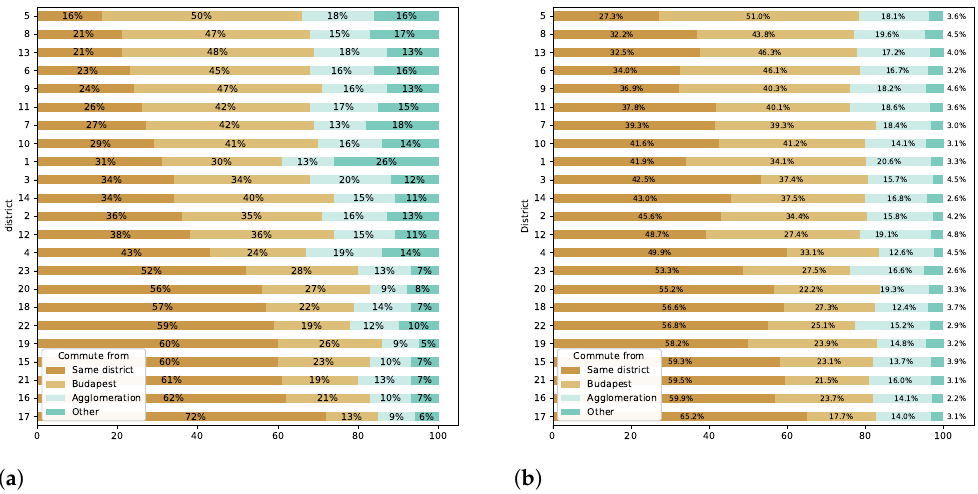
Figure 12. Comparison between the census-based ( a ) (Figure 1 in [9]) and the CDR ( b ) commuting ratios for the districts of Budapest, from the same district, other parts of Budapest, the agglomeration or out of the